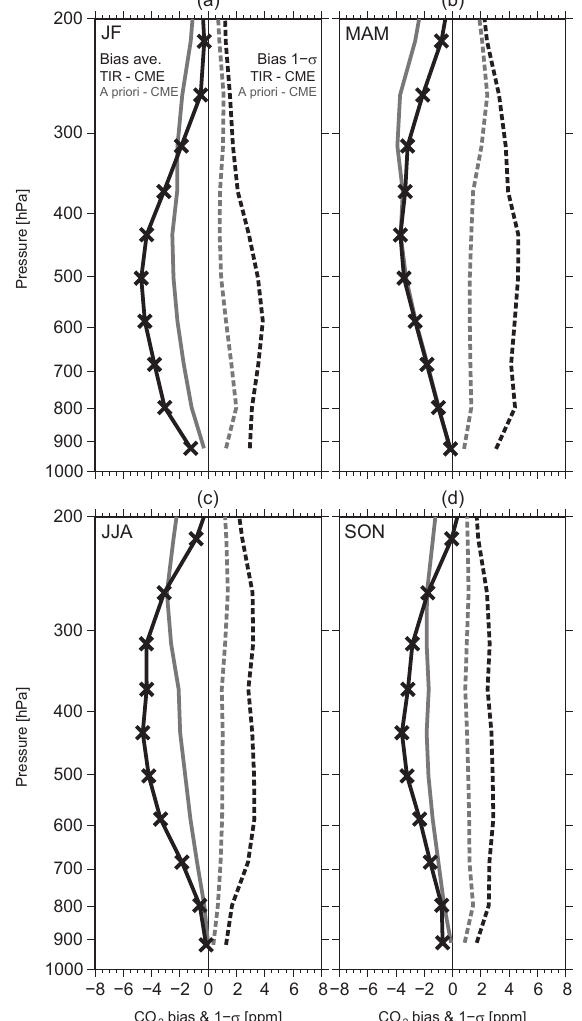
Figure 5. Bias profiles of GOSAT/TANSO-FTS TIR CO 2 data and a priori CO 2 data against CME_AK CO 2 data over Narita airport and the 1 σ standard deviations for each retrieval layer and season in 2010. The CME_AK CO 2 data are CME CO 2 data to which TIR CO 2 averaging kernel functions are applied. Solid black and gray lines indicate the biases of TIR and a priori CO 2 data, respectively, and dotted black and gray lines show their 1 σ standard deviations. Cross symbols indicate the center pressure level of each retrieval layer: (a) JF, (b) MAM, (c) JJA, and (d)